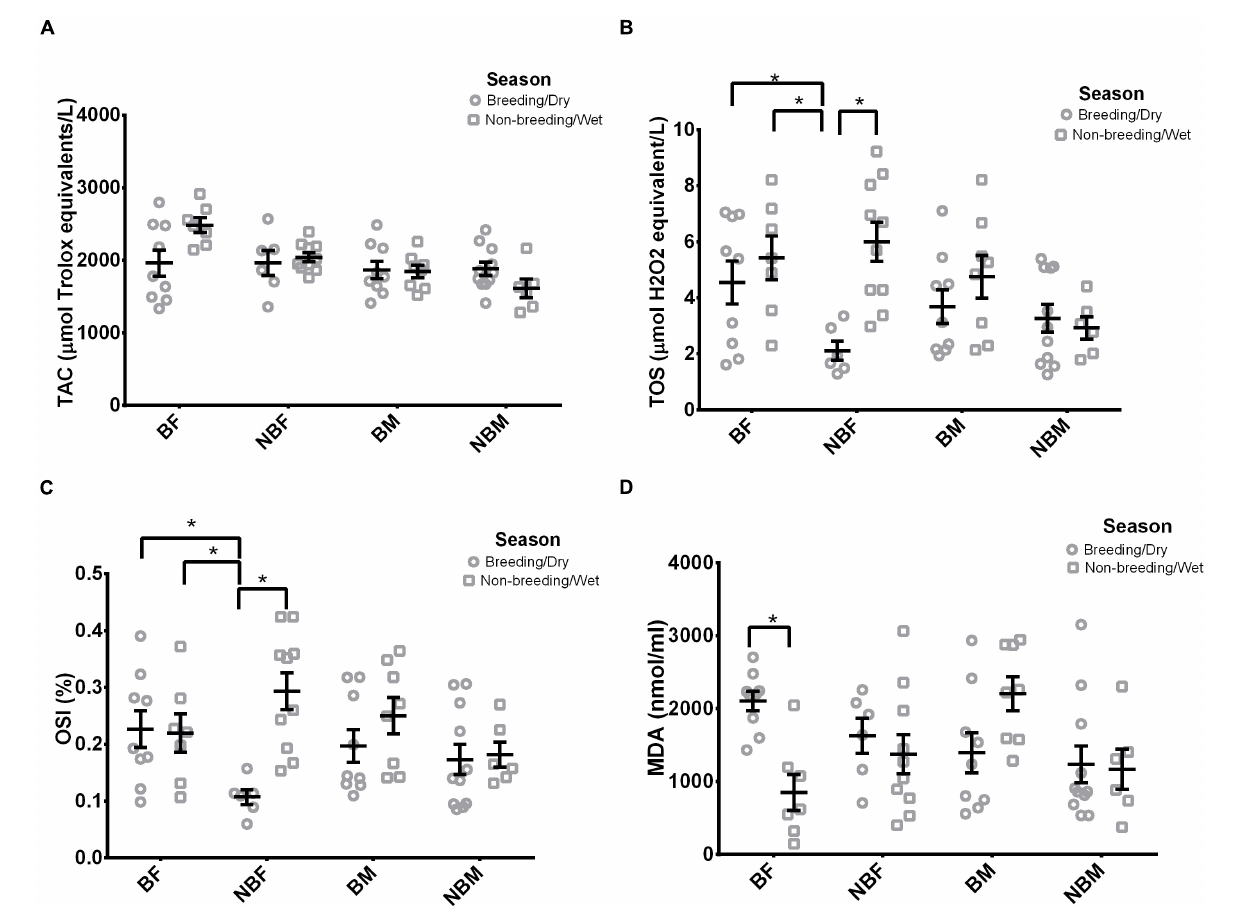
FIGURE 2 | The variation of (A) total antioxidant capacity (TAC- µ mol Trolox equivalents/L) (B) total oxidant status (TOS- µ mol H 2 O 2 equivalent/L) (C) oxidative stress index (OSI-%) and (D) malondialdehyde (MDA- nmol/ml) in highveld mole-rats ( Cryptomys hottentotus pretoriae ) between breeding (BF) and non-breeding (NBF) females, breeding (BM) and non-breeding males (NBM) across the non-breeding period/wet season and breeding period/dry season. Mean ± s.e.m. An asterisk (*) indicates significance ( p ≤ 0.05).